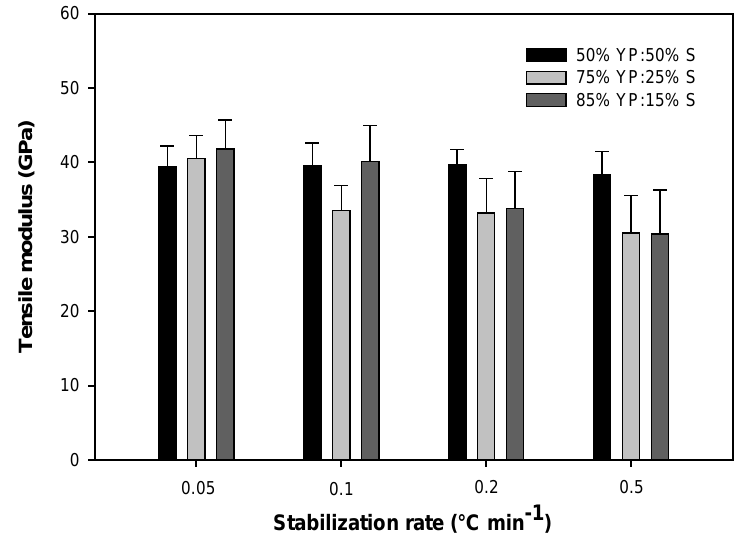
Figure 6. Effect of thermostabilization rate on tensile modulus of carbon fibers made from different ratios of switchgrass and yellow polar lignin blends.